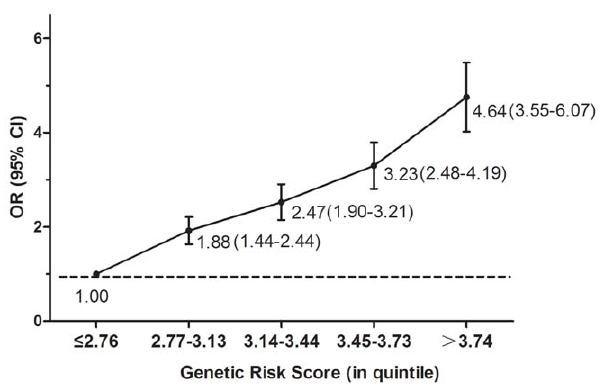
Figure 2. Distribution of risk for NPC by genetic risk score (in quintiles). Risk of NPC (expressed as OR 6 95% CI) was adjusted for age, sex, education level, dialect, residential area, family history of NPC, pack-years smoked, salted fish and preserved vegetables consumption. The boundaries for each genetic risk score quintile are shown on the x - axis.